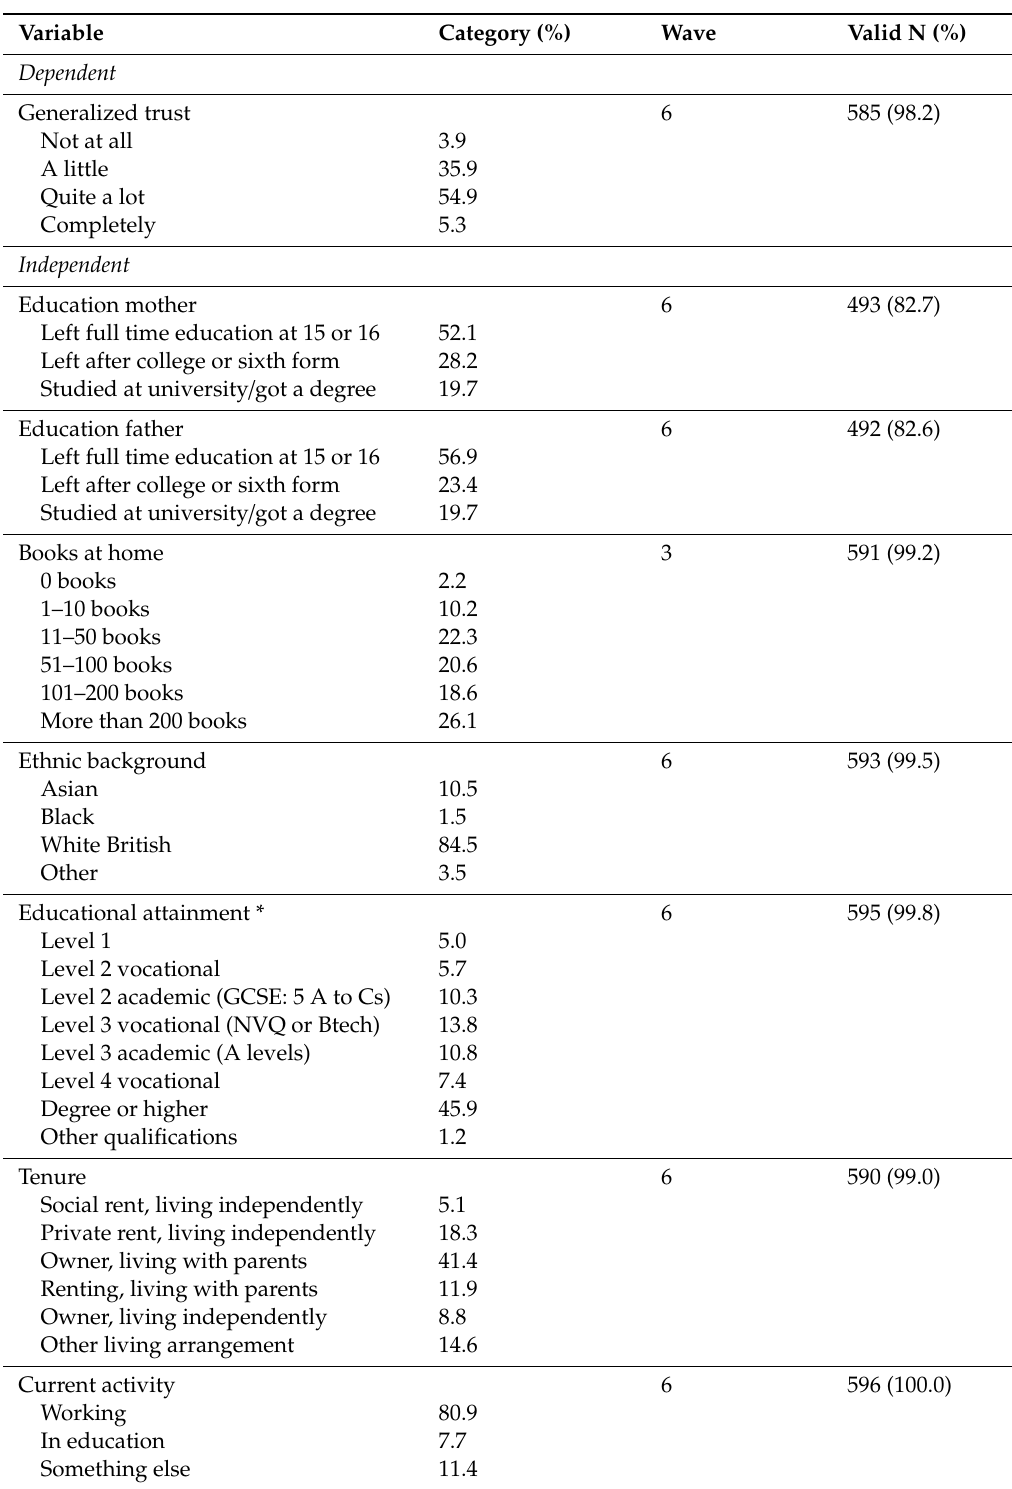
Table 1. Descriptive statistics of the dependent and independent